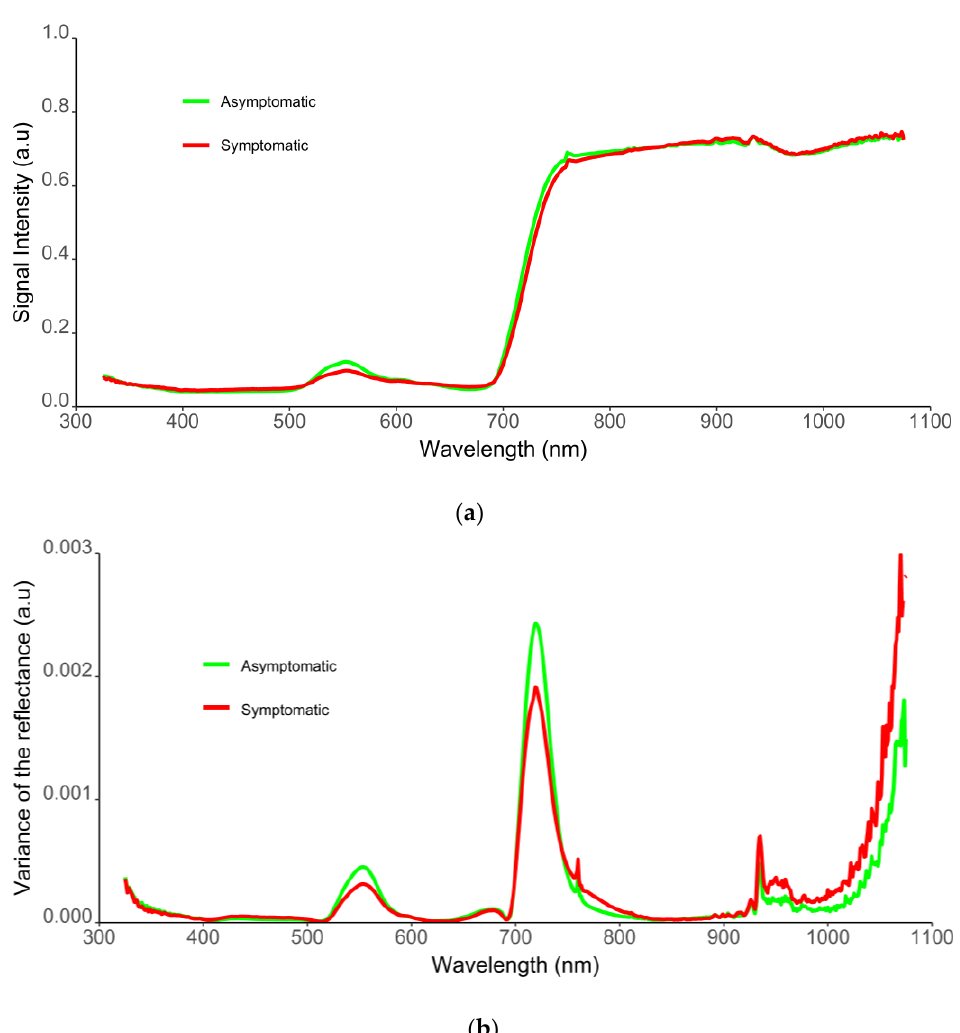
Figure 3. Percentage of correct classification predictions as ‘asymptomatic’ by date and test site using the SFVS strategy, followed by an SVM algorithm with radial kernel and class weights (stepsvmrw model). Values of BT site are represented with triangles and CT with circles. DOY — Day of the year.